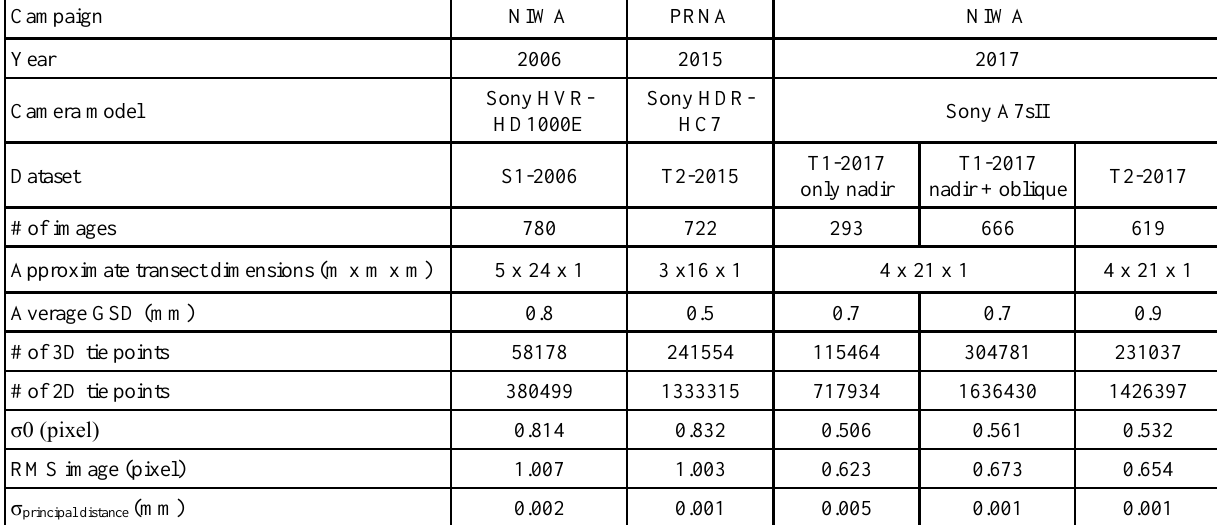
Table 1. Metadata, self-calibrating BA results and statistics of the processed video